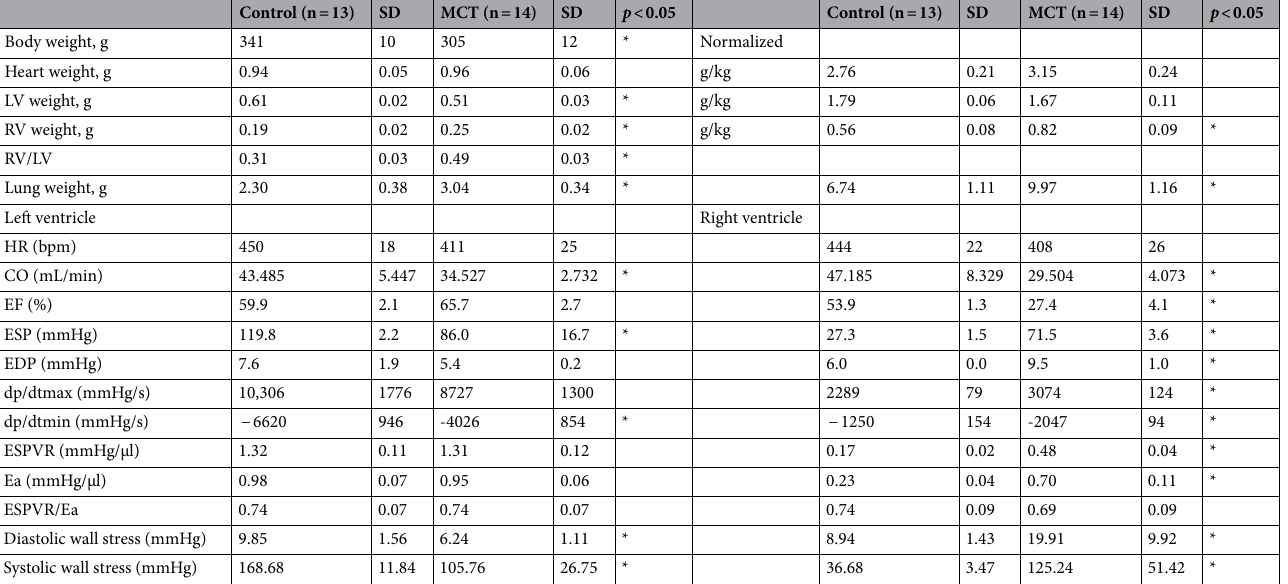
Table 1. Morphological and hemodynamic characteristics of monocrotaline- and saline-treated rats. CO cardiac output; Ea, arterial elastance; EF, ejection fraction; ESP, end-systolic pressure; EDP, end-diastolic pressure; ESPVR, end-systolic pressure–volume relationship; LV, left ventricle; RV, right ventricle; HR, heart